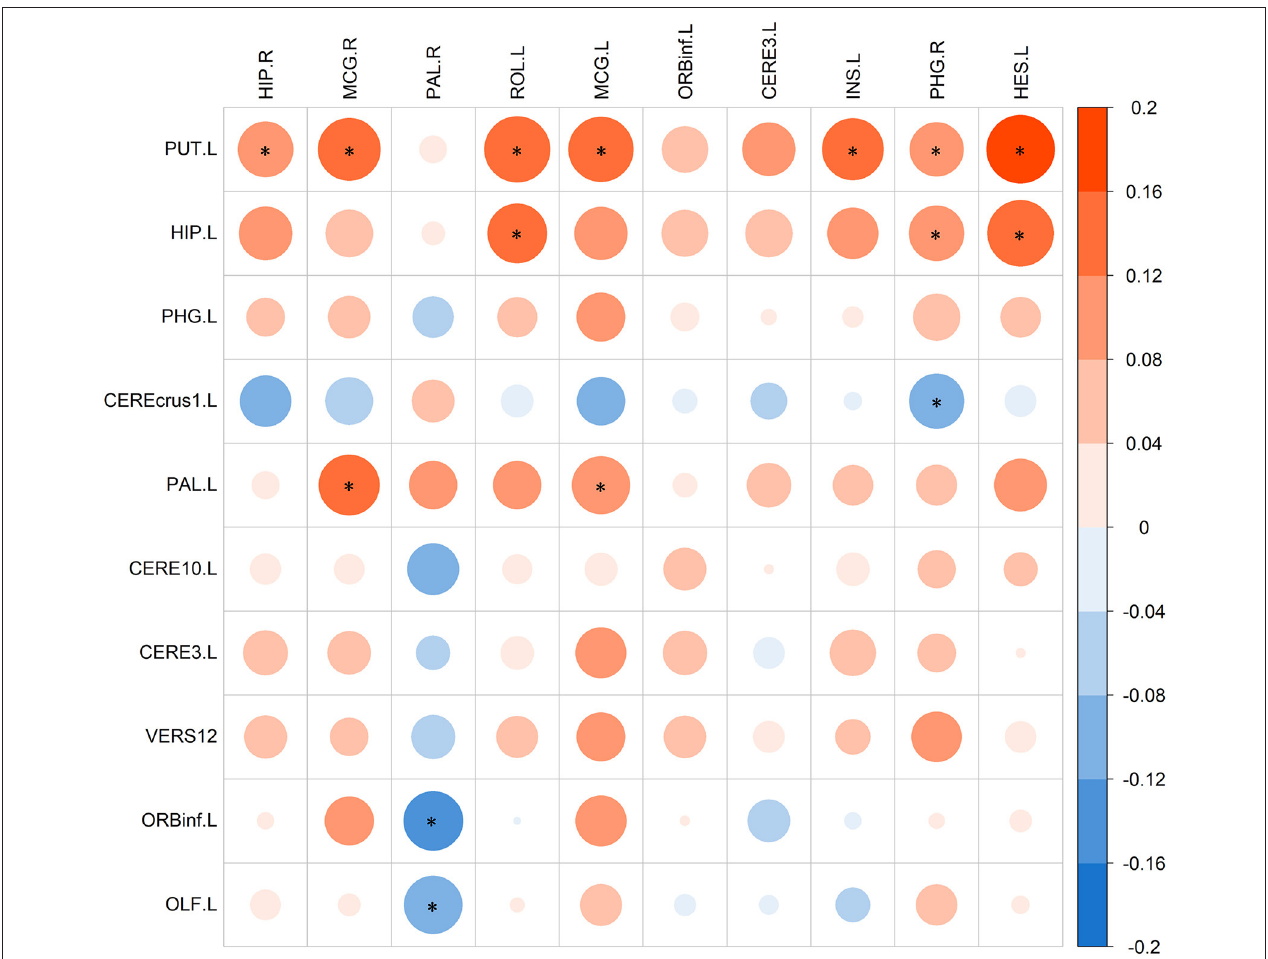
FIGURE 7 | The pairwise correlations between top 10 ROIs of d-fALFF (column) and top 10 ROIs of gray matter volume (row). Here * denotes p < 0.05.